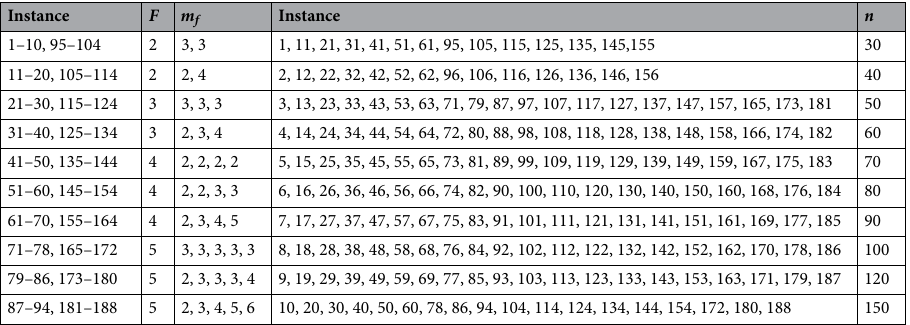
Table 2. Basic information on